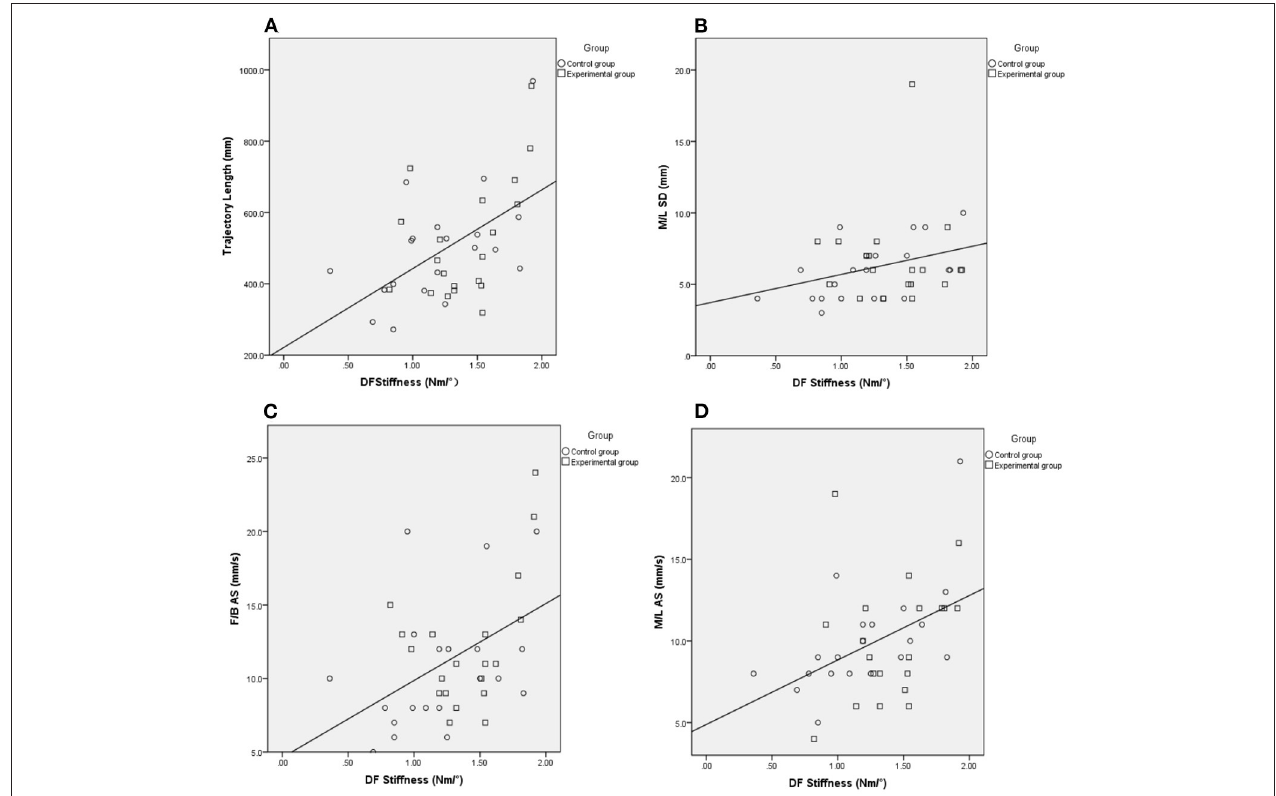
FIGURE 5 | The Spearman correlation analysis between DF stiffness and outcomes of the Pro-Kin test with eyes open. Trajectory length (A) , M/L SD (B) , F/B AS (C) , M/L AS (D) , Circle and Square indicate control, and experimental group. EO, Eye Open; F/B, Forward/Backward; M/L, Medial/Lateral; AS, Average Speed; SD, Standard